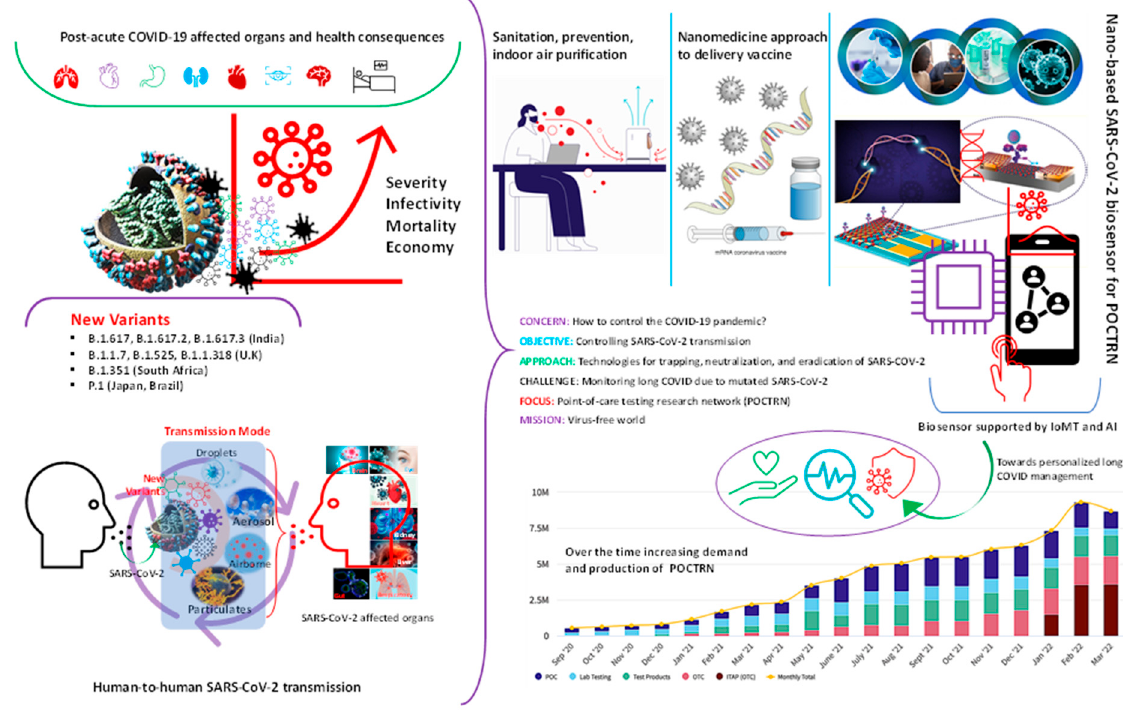
Figure 1. Schematic presentation of the status of the COVID-19 pandemic and recommendations on the development of smart sensors including wearable using a combinatory approach on biosensors supported with internet-of-medical-things (IoMT) and artificial intelligence (AI). The bar graph statistics on the bottom-right-hand side of the Figure are reprinted from https://www.nibib.nih.gov/covid-19/radx-tech-program/radx-tech-dashboard (accessed on 1 August 2022). Moreover, mutations of COVID-19 virus are rising and causing multiple outbreaks